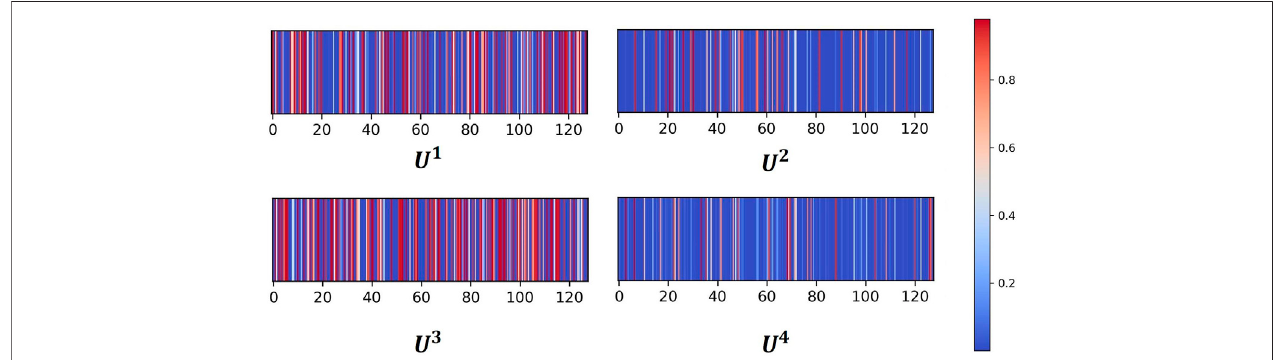
FIGURE 2 | The heatmap of attention coef fi cients for four modals.